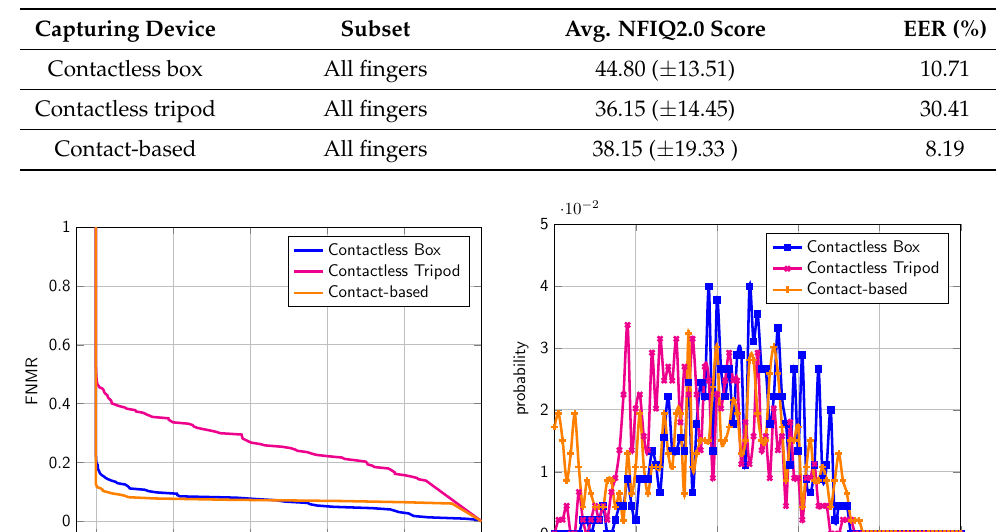
Table 4. Overview of the NFIQ2.0 quality scores and the EER of all captured fingers (finger-IDs 2–5 and 7–10) separated by sensors.